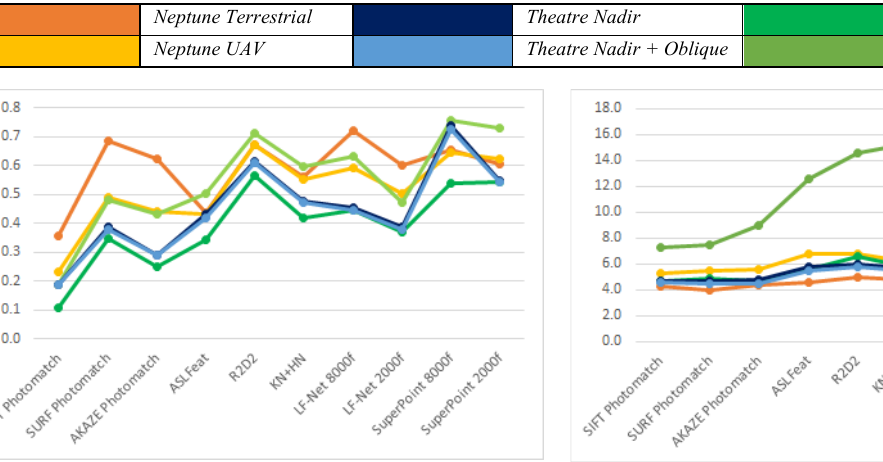
Figure 3: Mean reprojection error (MRE) [pixel] for the different datasets (see legend above) and tested methods.